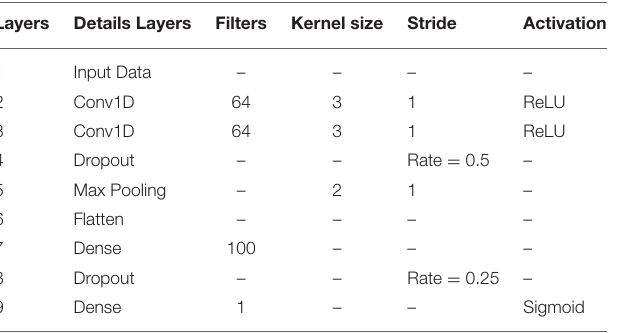
TABLE 1 | The details of the first proposed 1D-CNN model.